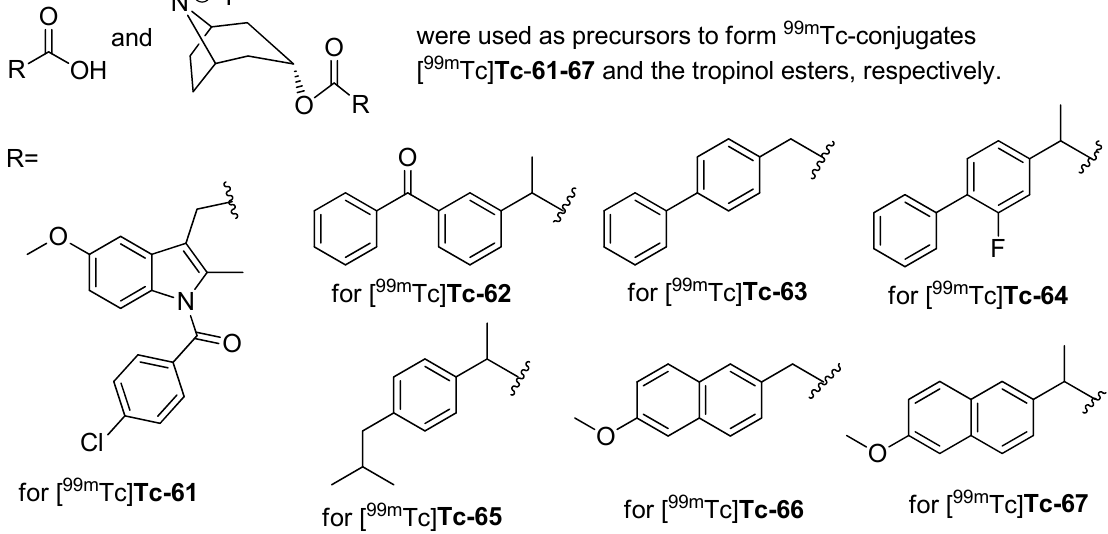
Figure 2. Structures of the labeling precursors for the synthesis of [ 99m Tc] Tc-61 – 67